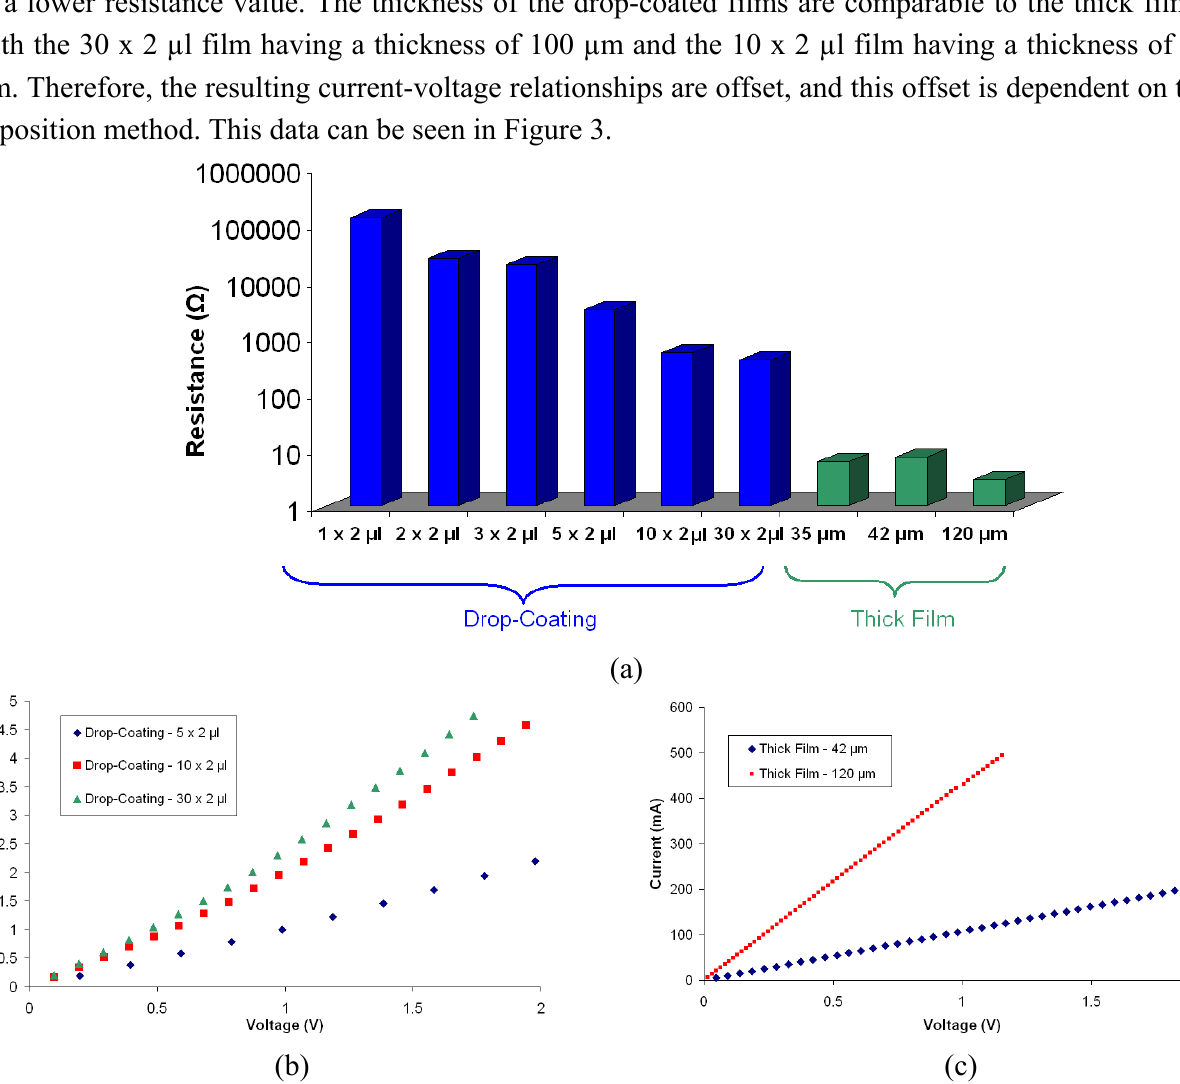
Figure 3. DC electrical characteristics of the various PANI films produced using both drop-coating and thick film deposition, showing: (a) the variation of resistance with deposition method; (b) the current-voltage relationship of the Drop-Coated films; and (c) the current-voltage relationship of the Thick